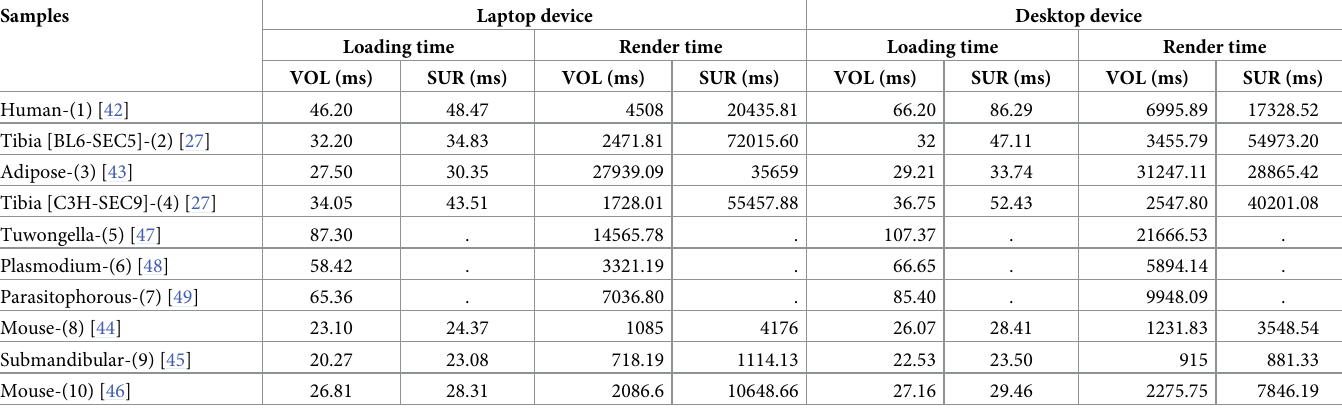
Table 2. 3D viewer performance measurement on laptop and desktop devices.